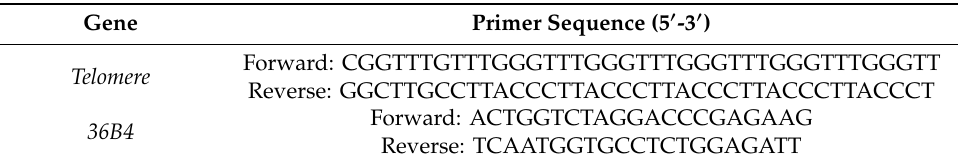
Table 3. Primer used in telomere length assessment.